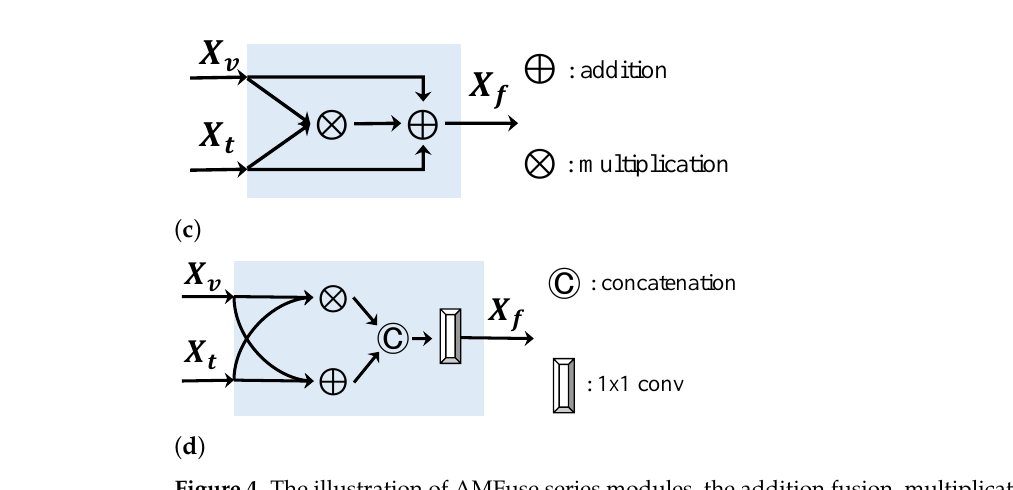
Figure 4. The illustration of AMFuse series modules, the addition fusion, multiplication fusion and their combinations. ( a ) AFuse; ( b ) MFuse; ( c ) AMFuse; ( d ) AMFuse+.